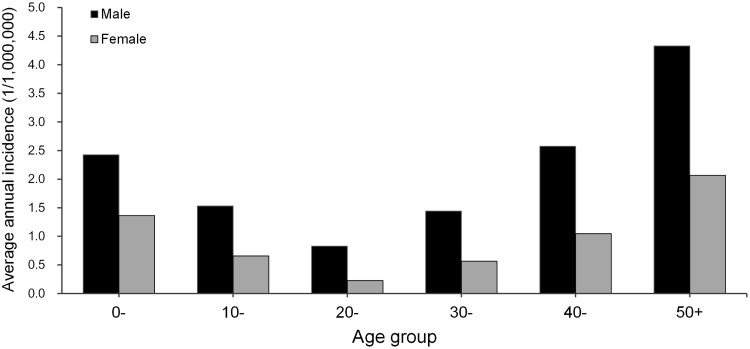
Human rabies incidence over gender and age group in mainland China.